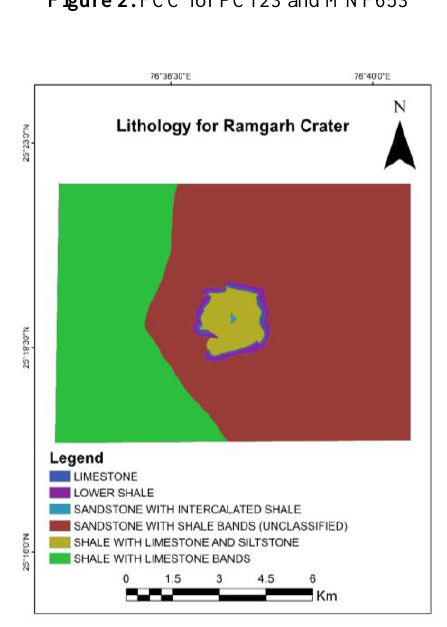
Figure 3. Lithology for Ramgarh astrobleme